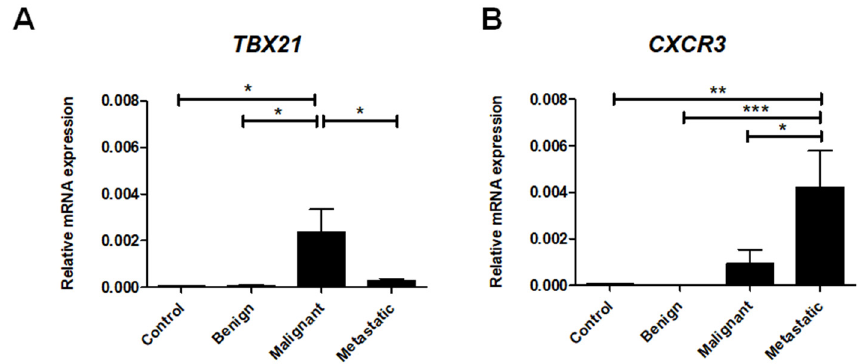
Figure 3. Th1 cell-associated gene expression levels in canine mammary tumors. The relative gene expression of CXCR3 ( A ) and TBX21 ( B ) in healthy mammary gland tissue (Control) and in benign, malignant, and metastatic canine mammary tumors. The results are presented as the mean ± SEM. A one-way ANOVA and Tukey HSD post hoc test were applied. Significance levels are indicated as follows: * p < 0.05; ** p < 0.01; *** p < 0.001.